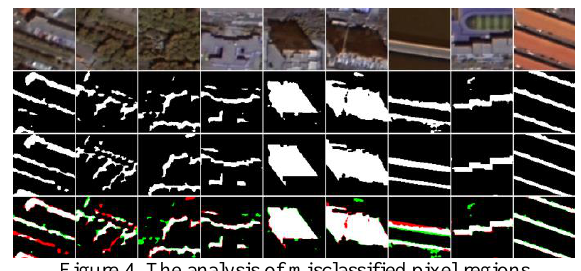
Figure 4. The analysis of misclassified pixel regions